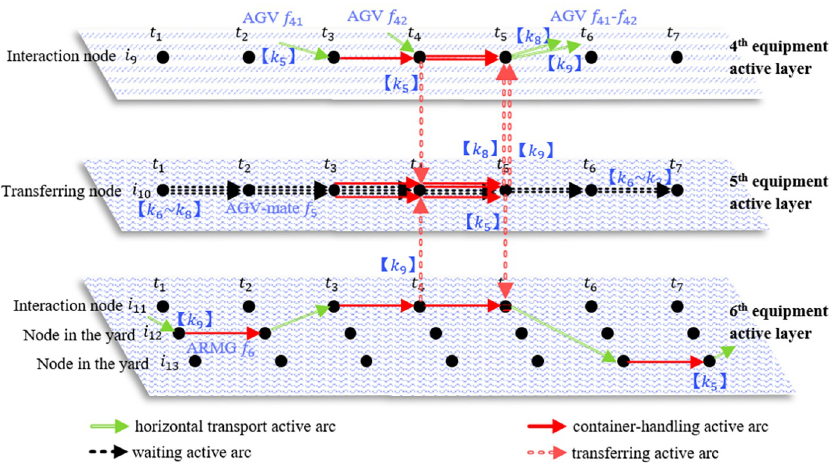
Fig 7. An example of the space-time representation of the cooperative operation corresponding to the AGV-mate.